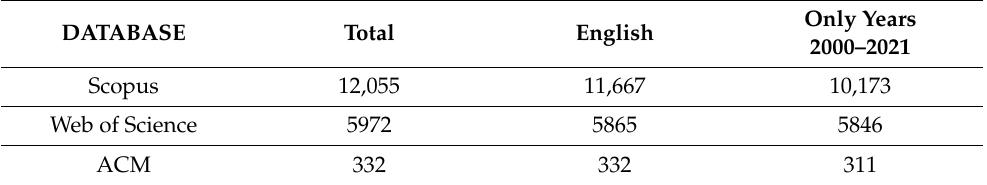
Only Years 2000–2021